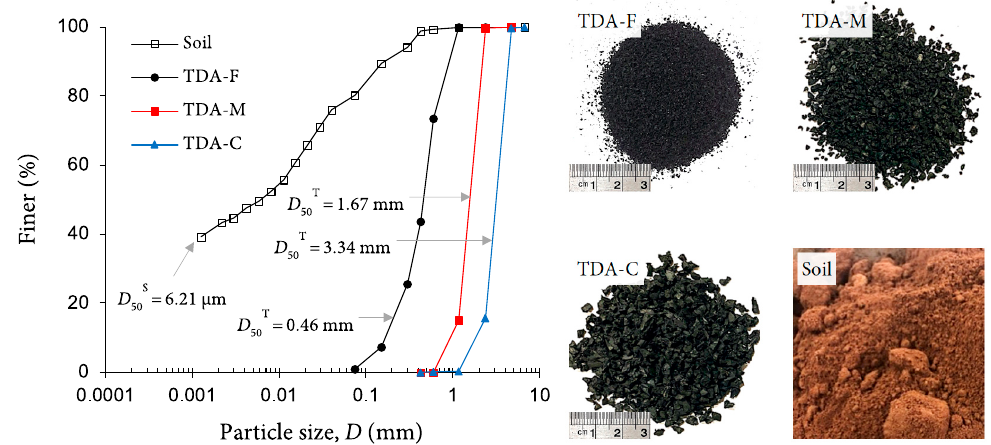
Figure 1. Gradation curves for the test materials.